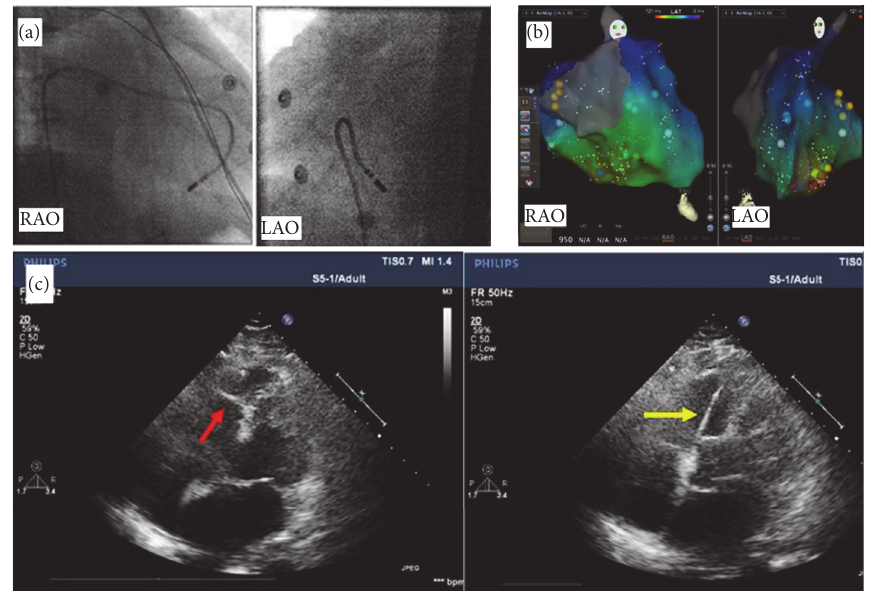
Figure 3: (a) Ablation catheter at the earliest activation site on the MB using fluoroscopy. (b) Electroanatomic mapping showed that the ablation zone (red points) was placed at the site of earliest activation at the middle RV of lower septum. (c) Ablation at the earliest activation site on the MB (red arrow) guiding by TTE; the ablation catheter (yellow arrow) was placed at the septum insertion of MB. RAO: right anterior oblique; LAO: left anterior